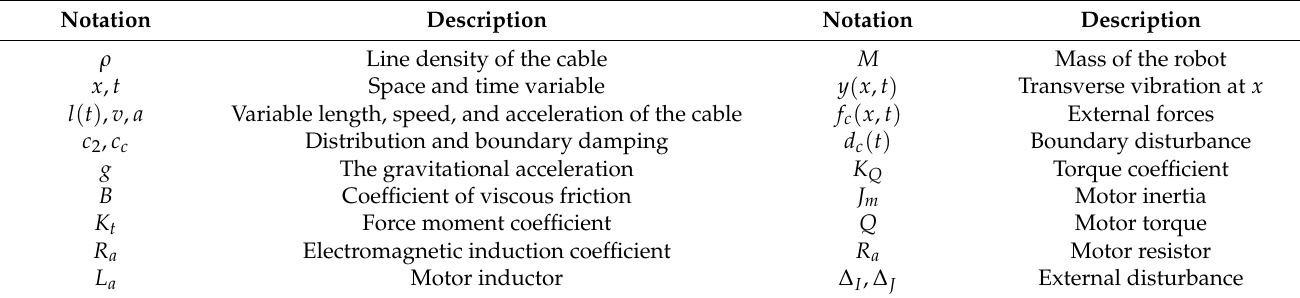
Table 1. The notations in the